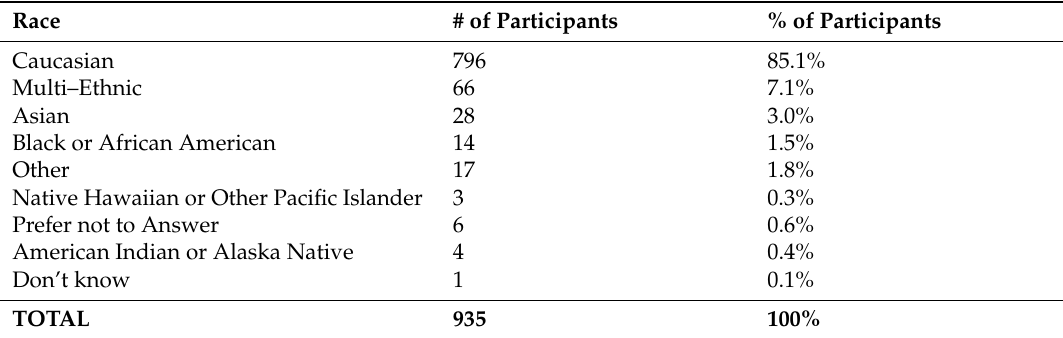
Table 6. Race of participants within the Global PWS Registry.